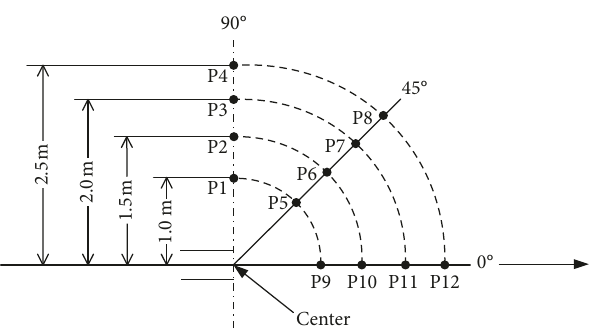
Figure 6: Field diagram (red line indicates the axis of different angles according to barrel axis; red circle indicates microphone location).